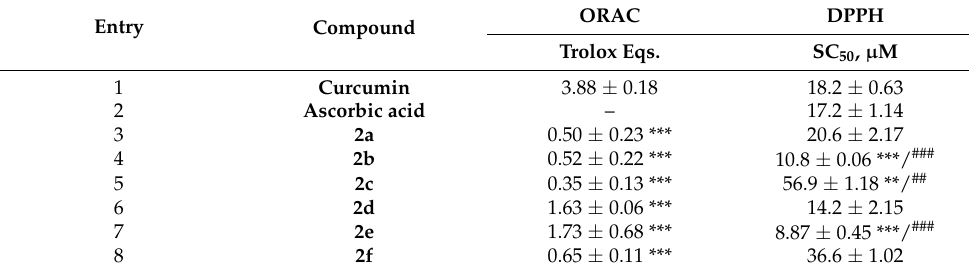
Table 3. Antioxidant activity of compounds 2a – f at the ORAC and DPPH assays a